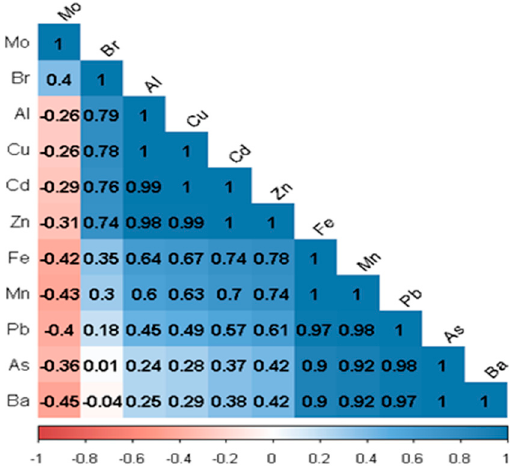
Figure 6. Surface water correlation matrix.